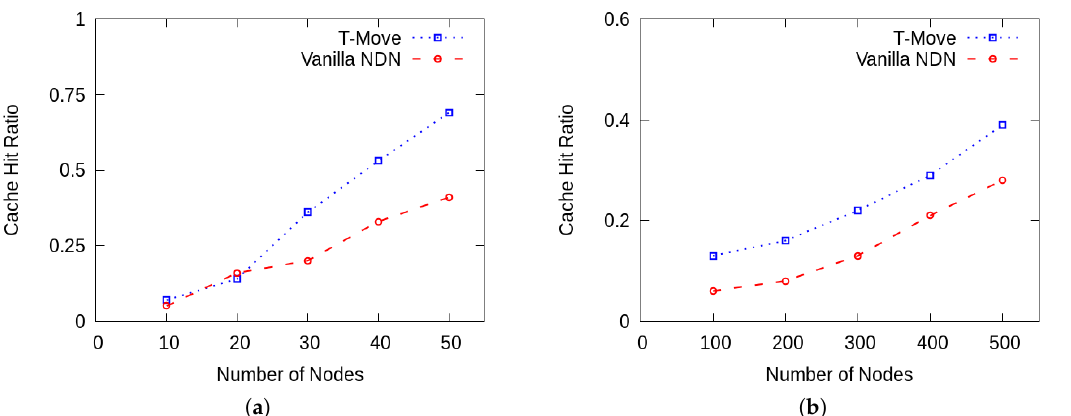
Figure 5. ( a ) Effect of the Number of Nodes on the Cache Hit Ratio (Topology 1); ( b ) Effect of the Number of Nodes on the Cache Hit Ratio (Topology